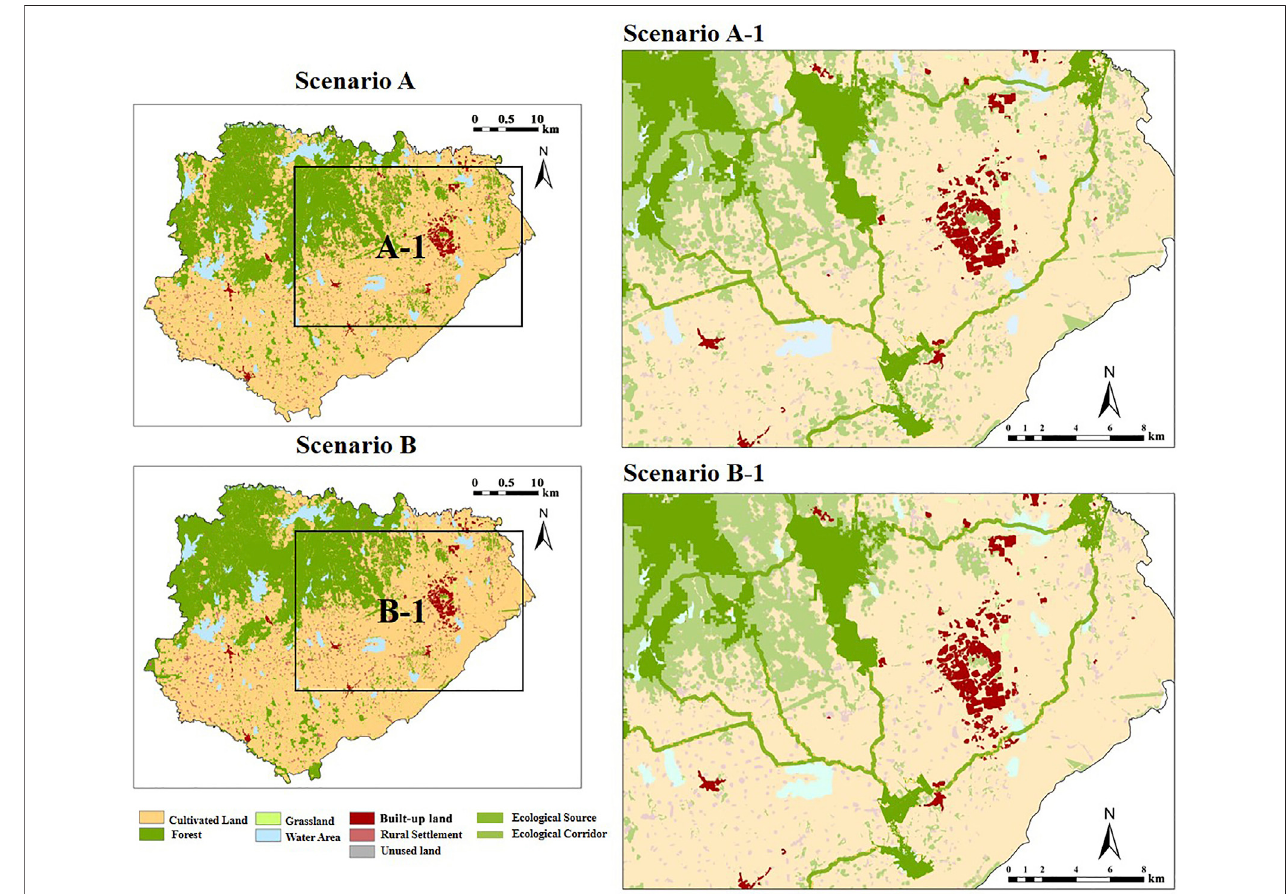
FIGURE 7 | Simulated LULC change from 2018 to 2030 under Scenario A and Scenario B in Quanjiao County.